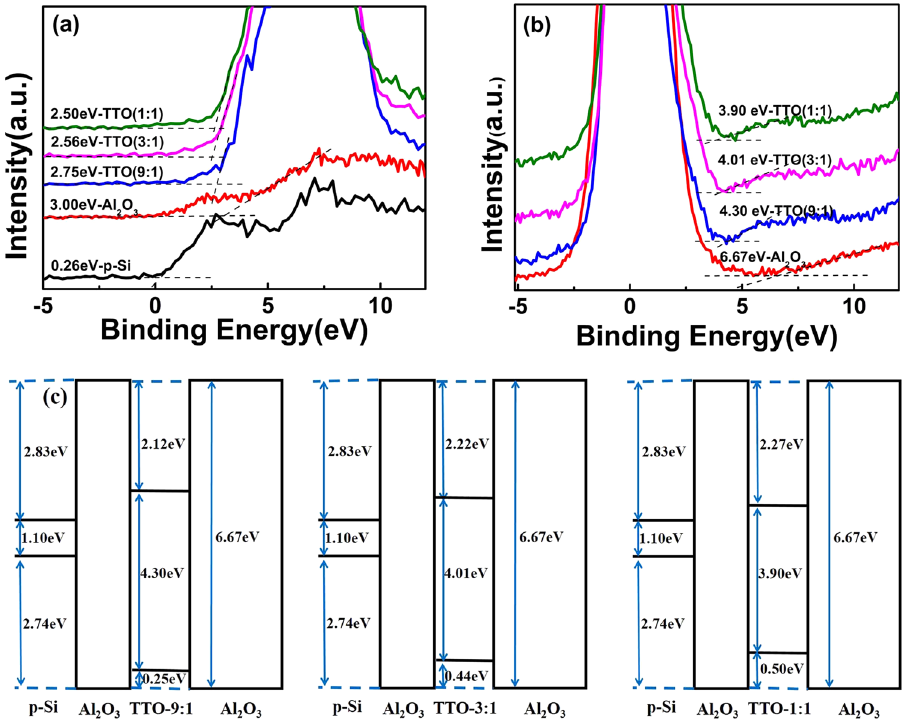
Figure 3. The valence band spectra of TTO composite samples, Al 2 O 3 and p-Si substrate ( a ), O 1 s energy loss spectra of TTO composite samples and Al 2 O 3 ( b ), and the band alignments of TTO CTM devices ( c